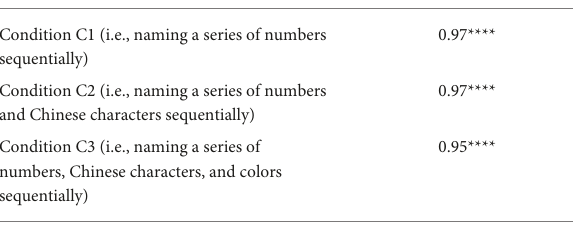
Correlation coefficient